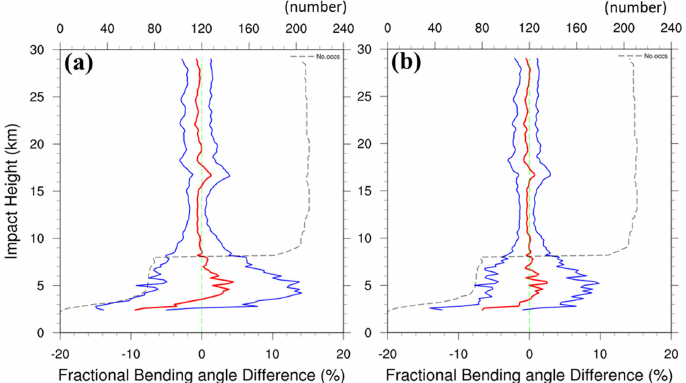
Figure 12. The vertical profiles of mean fractional differences (red) in bending angle and their standard deviations (blue) between ( a ) the observation (O) and the first guess (B) during the data assimilation for BND_H (i.e., (O − B)/B in %) (similar to BND but with the resolution of 60-15-3 km), and ( b ) as in ( a ) but for the observation (O) and the analysis (A), i.e., (O − A)/A. The black dashed line indicates the number of all GPS RO soundings used in the verification area (see Figure 2) during the data assimilation. The vertical profiles are shown as impact height (km).